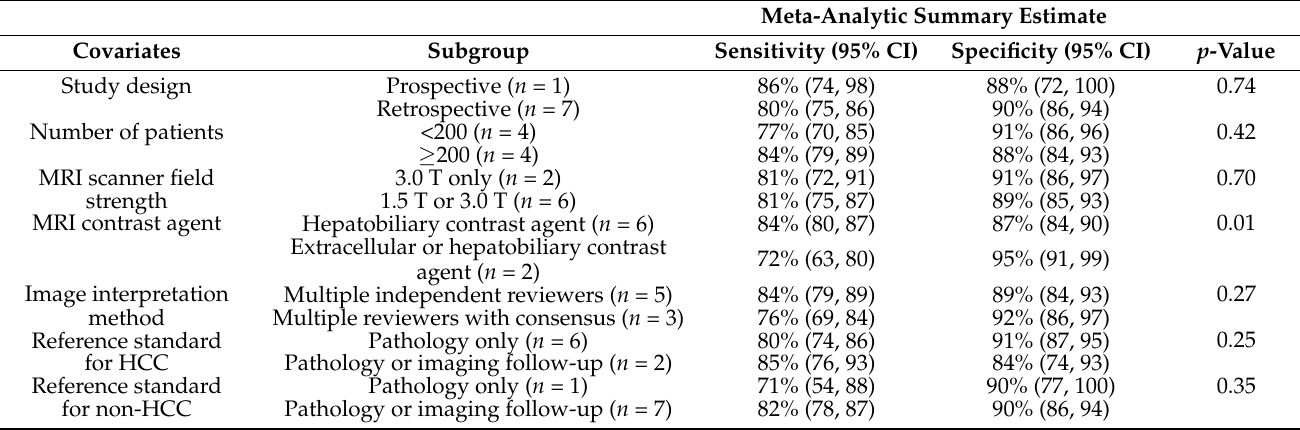
Table 3. Results of meta-regression analysis of the accuracy of definite HCC criteria of KLCA-NCC 2018 for diagnosing HCC.